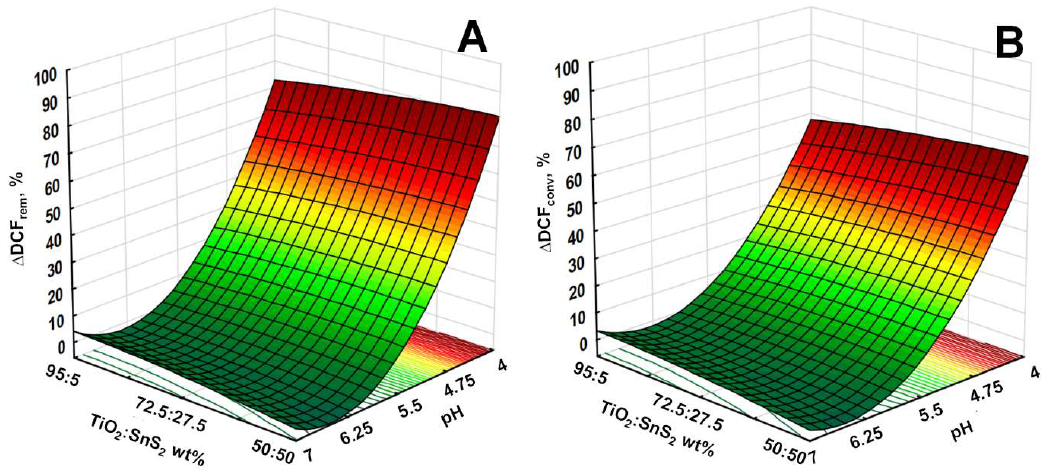
Figure 7. 3D response surface and contour diagrams showing the effects of the mutual interactions of initial pH and SnS 2 wt % on DCF removal ( A ) and conversion ( B ) by solar/TiO 2 -SnS 2